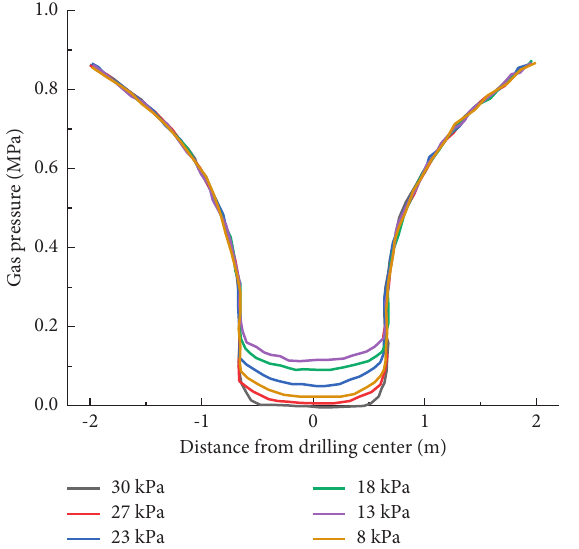
Figure 4: The variation of effective gas extraction radius with time under different extraction negative